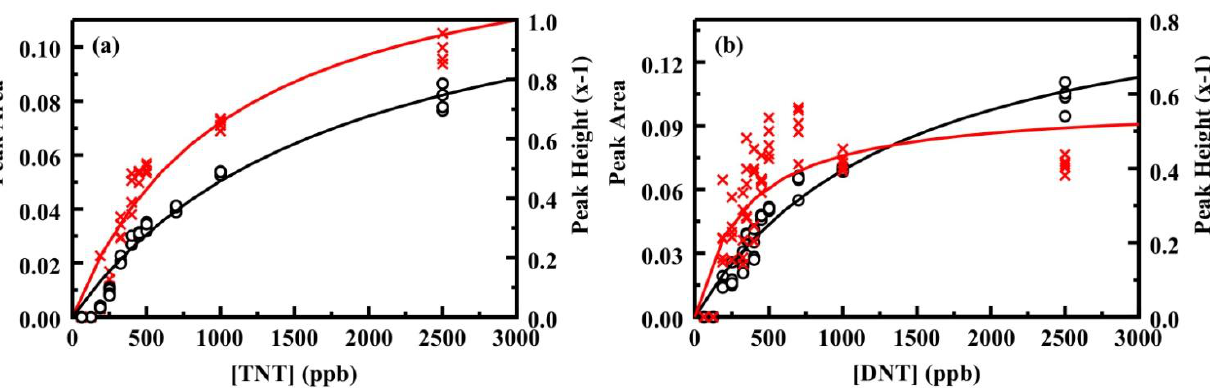
Figure 2. Calibration of the electrochemical sensor against ( a ) TNT (−0.62 V ±0.02) and ( b ) DNT (−0.77 ± 0.02) in 100 mM potassium chloride with 50% methanol. The complete data set is provided in the Supporting Information, Tables S2 and